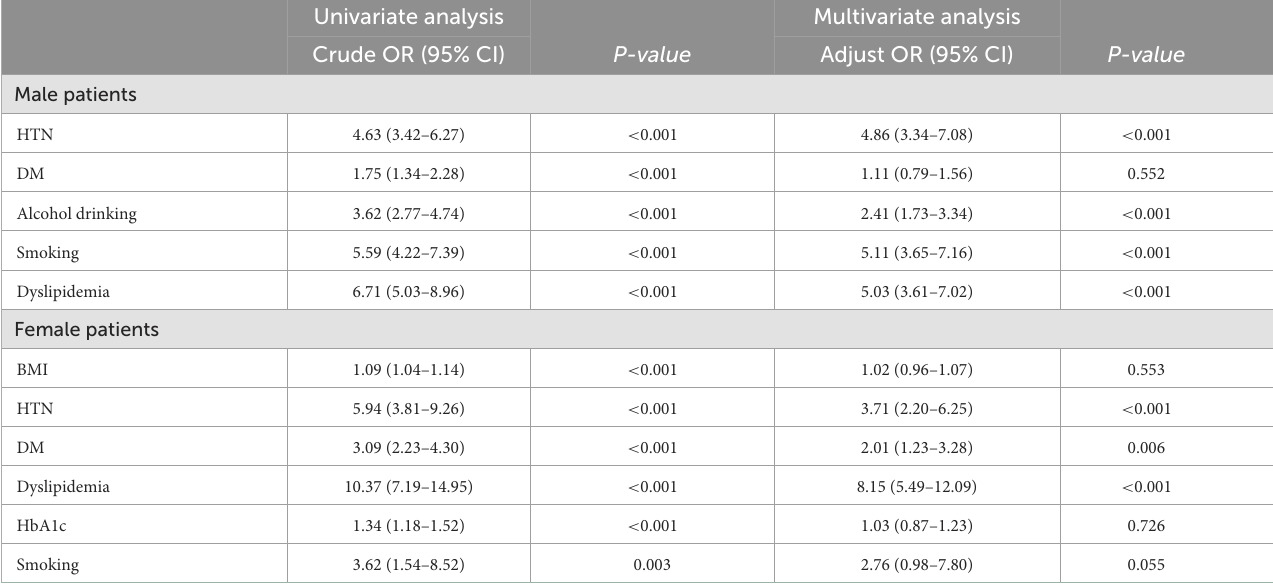
TABLE 4 Factors related to recurrent ischemic stroke in males and females. Univariate